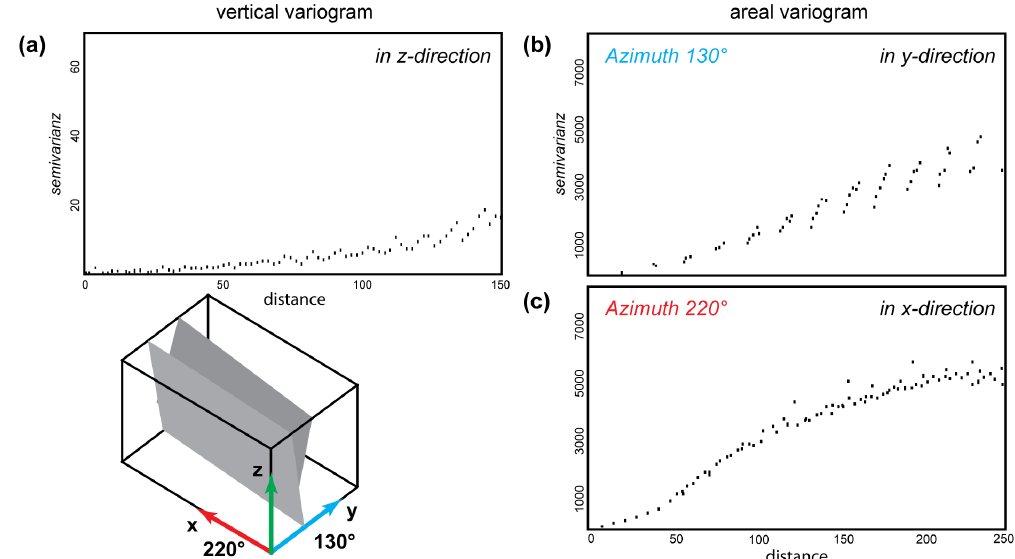
Figure 8. 3D variograms for the SGrid of Sector B. The visualized property is Nb, and variograms are calculated ( a ) vertical, ( b ) perpendicular (130 ◦ ), and ( c ) parallel (220 ◦ ) to the faults (see Figure 3). Parameters used: number of lags: 125, lag distance: 2 m, number of strata: 100, azimuths: 130 ◦ and 210 ◦ , tolerance: 20, bandwidth: 50, number of x and y columns: